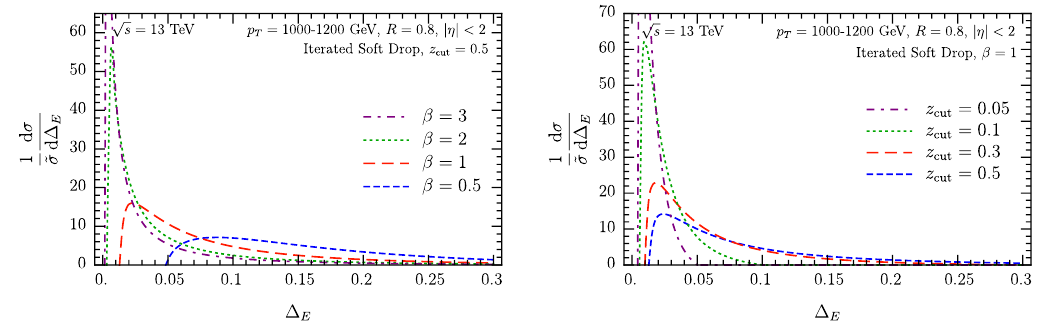
Figure 8 . The jet energy drop for iterated soft drop at NLL 0 for several values of β (left) and z cut (right).